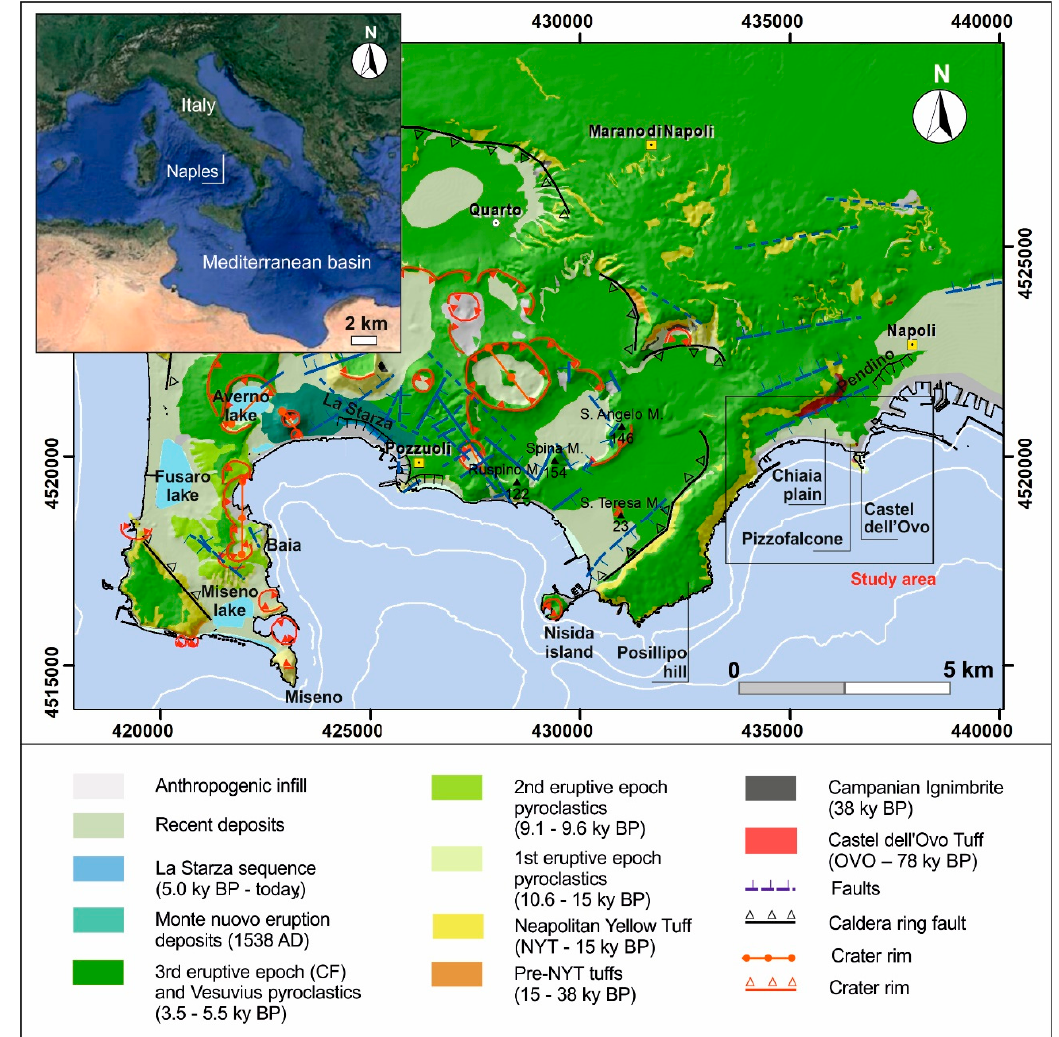
Figure 1. Geological sketch of Naples and Campi Flegrei (after Isaia et al.,[71]; DiVito et al.,[68]).